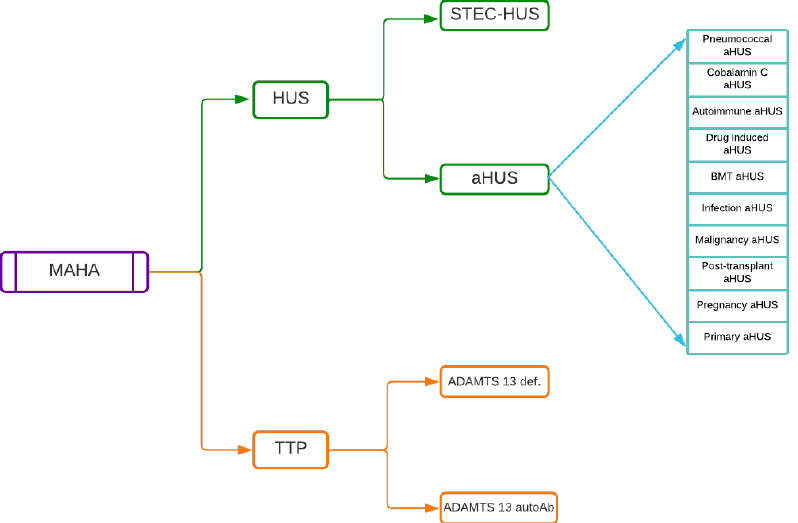
Figure 5. Pathological entities in differential diagnosis of MAHA. After Goodship et al., 2017 [21], MAHA—Microangiopathic hemolytic anemia; HUS—hemolytic uremic syndrome; STEC—Shiga- Toxin E. coli ; aHUS—atypical hemolytic uremic syndrome; BMT—bone marrow transplant; TTP— thrombotic thromboangiopathic purpura.